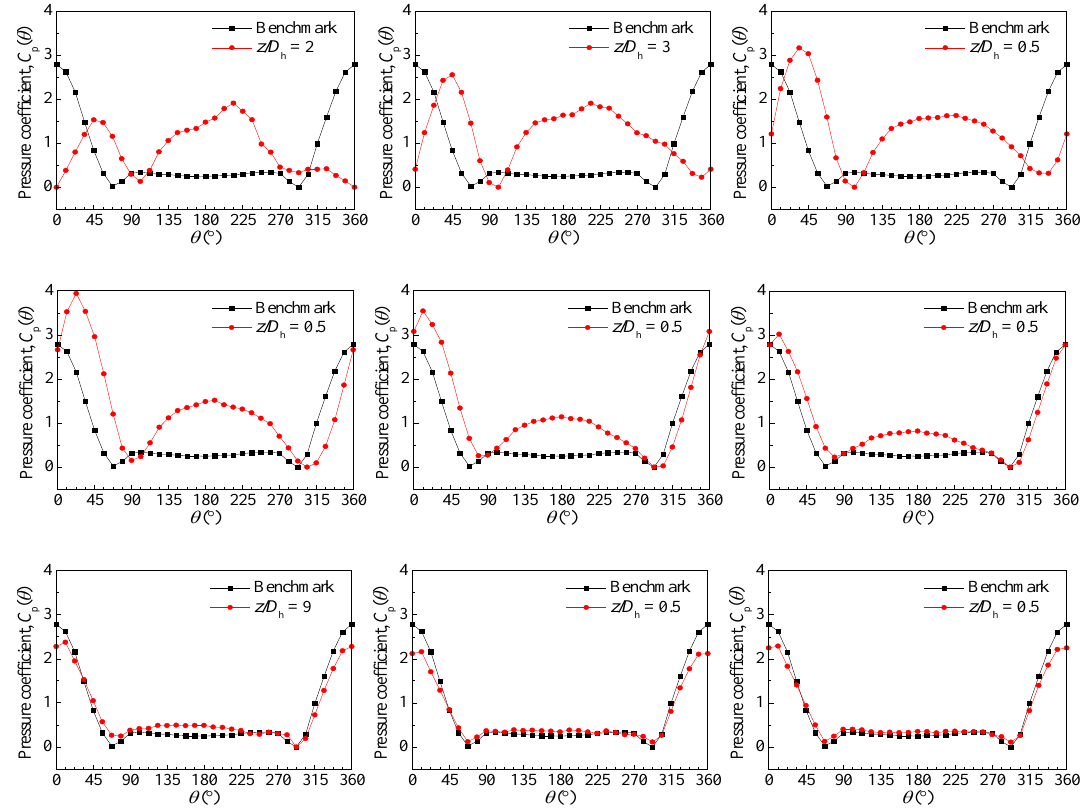
Figure 8. Pressure distributions at different positions at R = 0.117 without vanes.